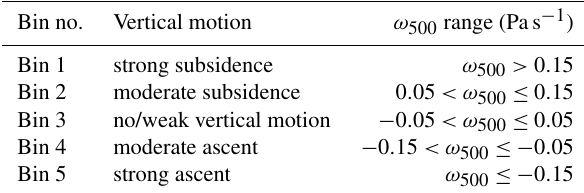
Table 1. Definition of the ω 500